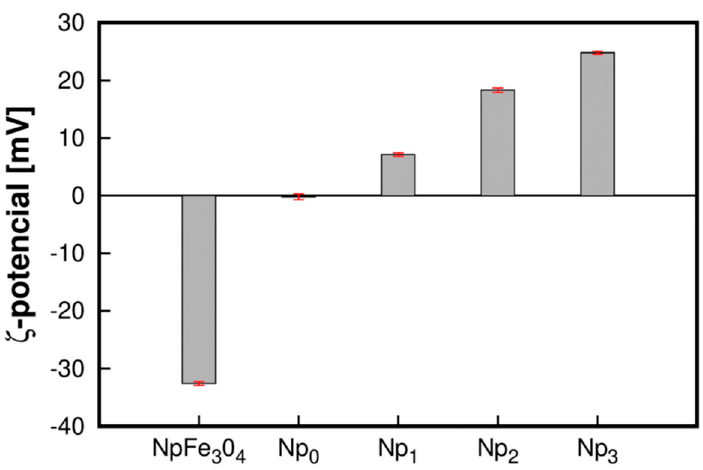
Figure 5. ζ -Potential of Fe 3 O 4 Nps and samples of Np 0 , Np 1 , Np 2 , and Np 3 , determined by sizer-nano ZS.